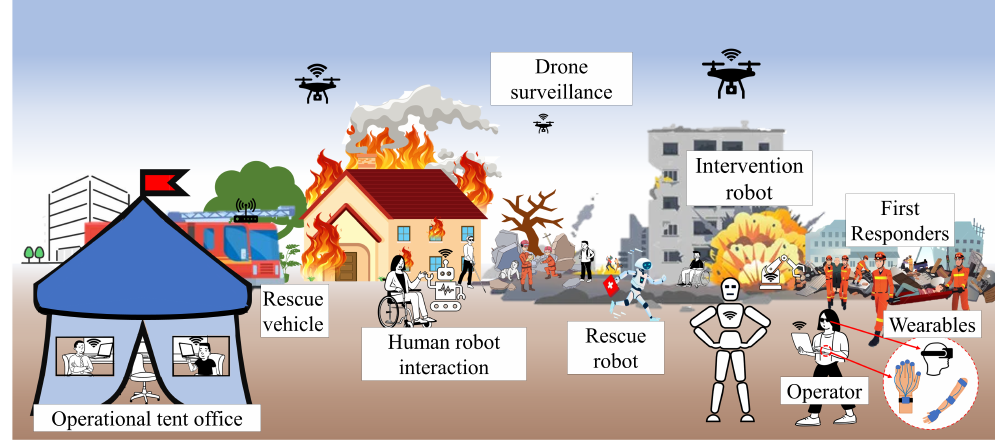
Figure 3. An illustration of a disaster to highlight the range of individuals and technologies that can be involved in SAR